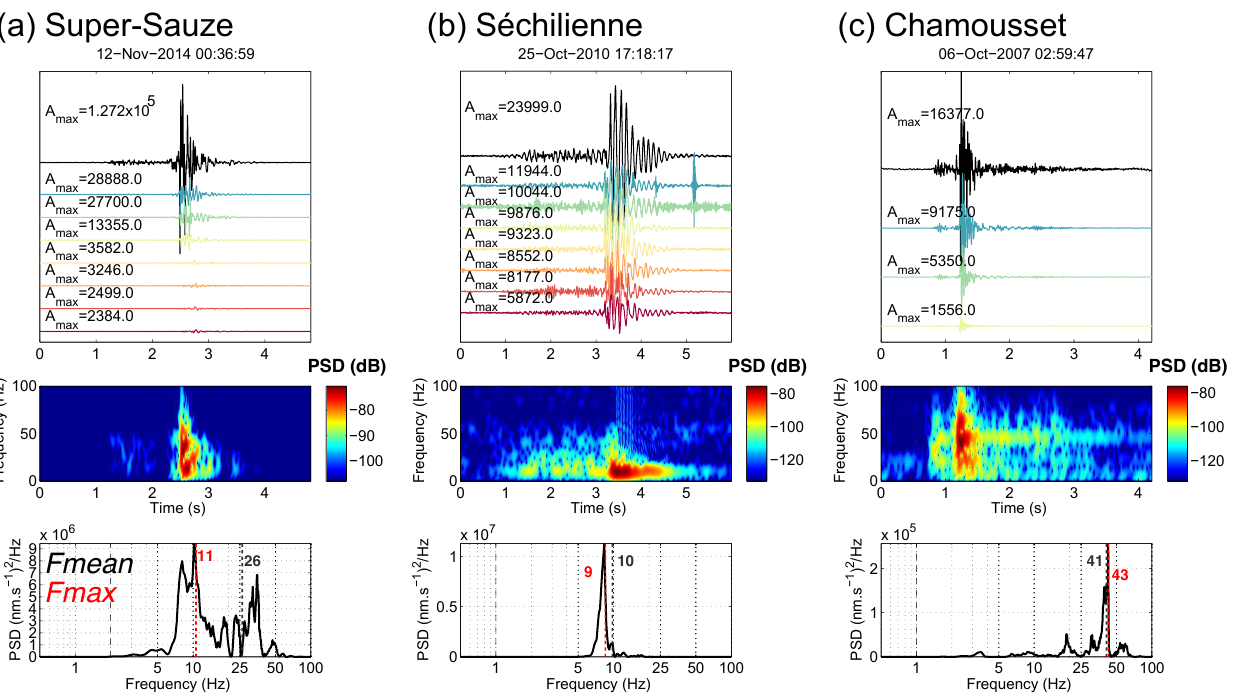
Figure 9. Examples of slopequakes with precursory events recorded at the (a) Super-Sauze, (b) Séchilienne and (c) Chamousset slopes. See Fig. 2 for a description of the